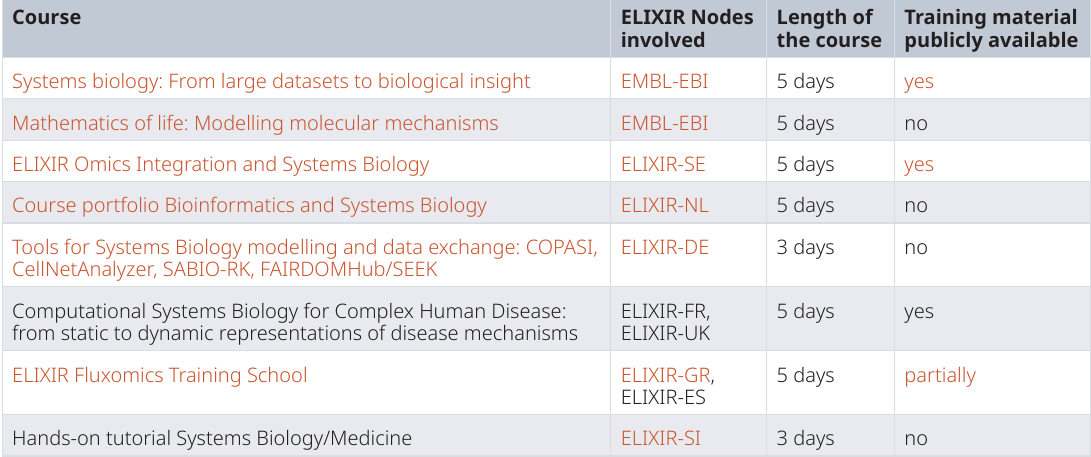
Table 3. Examples of systems biology courses across the ELIXIR